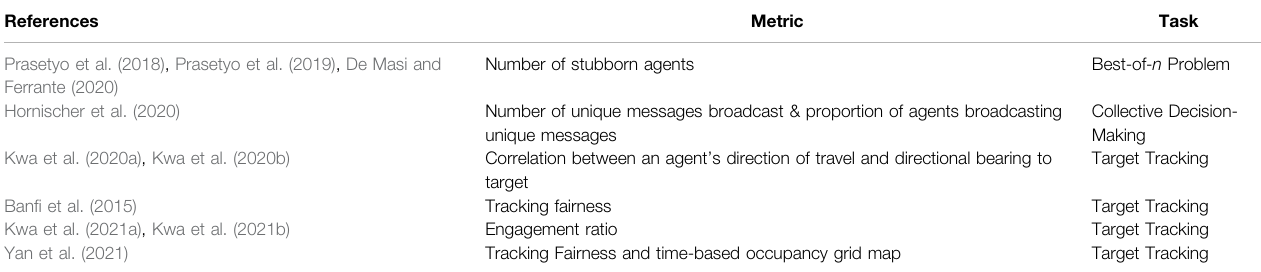
TABLE 3 | List of works using their own developed methods or metrics to quantify the level exploration and exploitation carried out by an